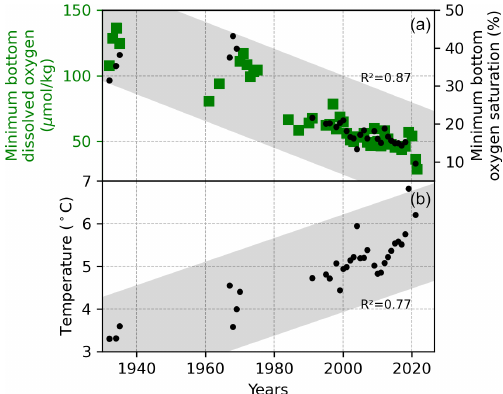
Figure 4. Minimum bottom-water dissolved oxygen (DO) concen- trations at the head of the LSLE (a) , and associated water tempera- tures (b) . The grey bands indicate the trend, based on a linear least- squares fit to the data, with the R 2 indicated on the figure. This figure offers a crude estimate of the trend in the bottom-water prop- erties, given that the exact sampling depth, although always below 250m, might have varied over the